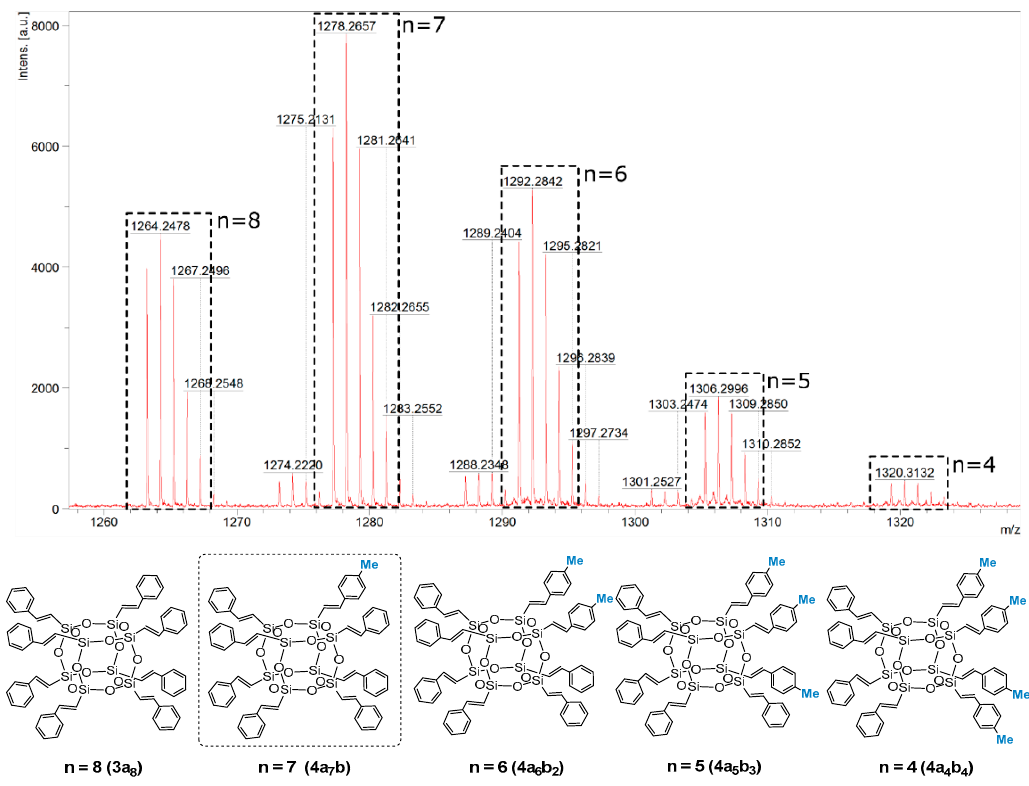
Figure 2. MALDI-TOF and structures with respective styrene substitutions present in the reaction mixture (Me–C 6 H 4 –CH=CH–) 8 − n (C 6 H 5 –CH=CH–) n Si 8 O 12 (where n = 8, 7, 6, 5, 4) with a predominance of the designated 4a 7 b.